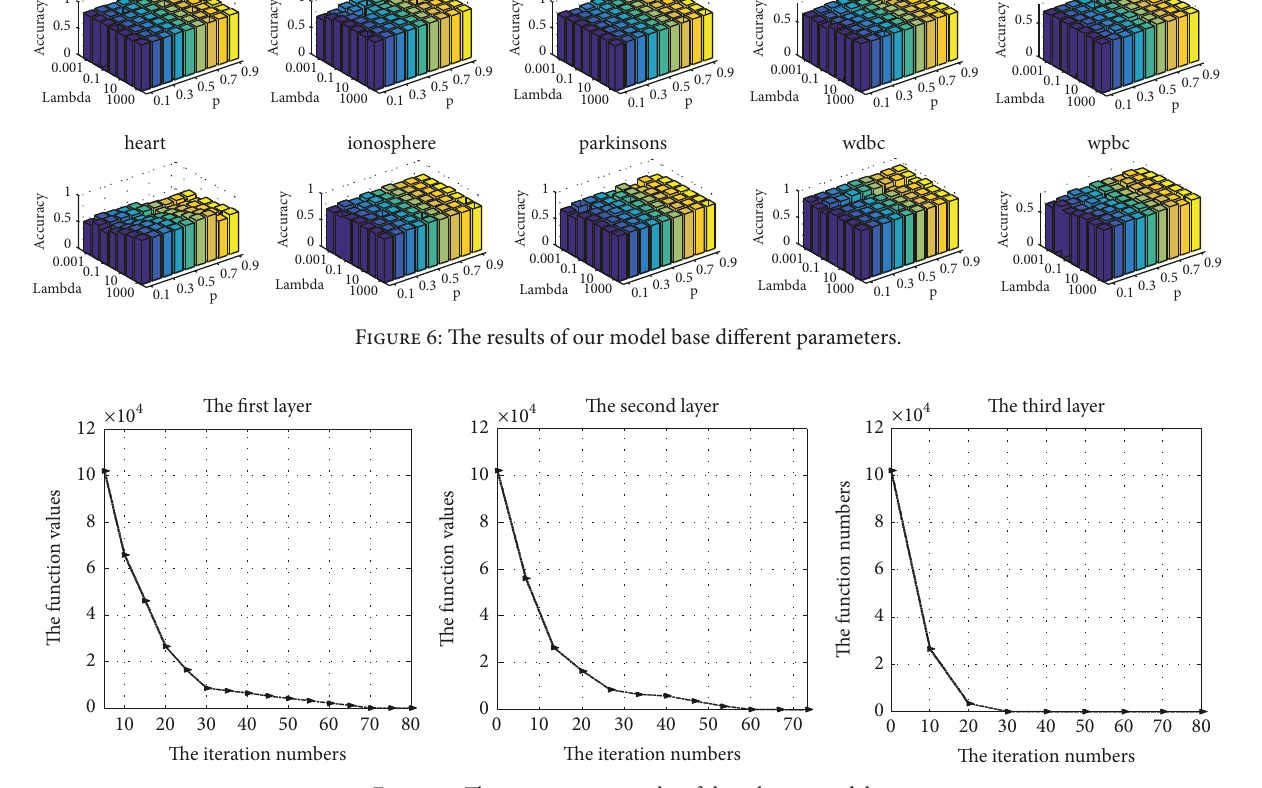
Figure 7: The convergence results of three layers